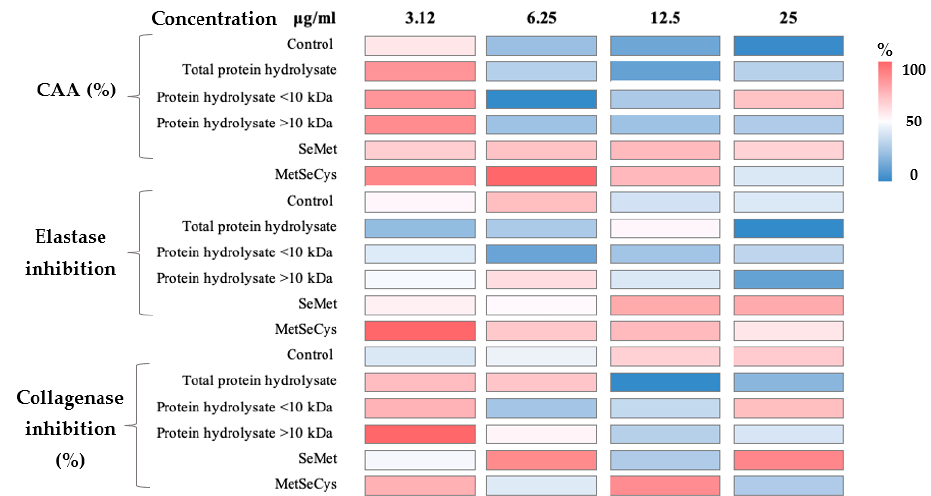
Figure 3. Heat map of the cellular antioxidant activity (CAA) in HDFa cells, elastase inhibition (%), and collagenase inhibition (%) in a range of concentrations from 25 to 3.12 µg/mL of each sample. The complete table is presented in the Supplementary material Table S1. Colors represent the % of the activity of inhibition compared by assays. SeMet: selenomethionine, MetSeCys: methyl selenocysteine.